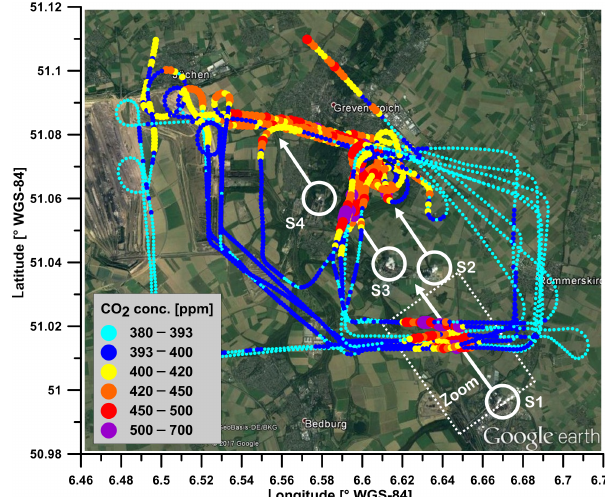
Figure 2. The in situ flight pattern around and between the four sources (S1: Niederaußem; S2: Neurath (new); S3: Neurath (old); S4: Frimmersdorf), with the wind direction (white darts, from 146 ◦ ). The CO 2 concentrations (1 dot per 3s-average, i.e. about every 120m) are colour coded. In the north, the flight pattern was along an airspace that could not be entered. Also, on top, the cross sections were limited to 3500ftAMSL